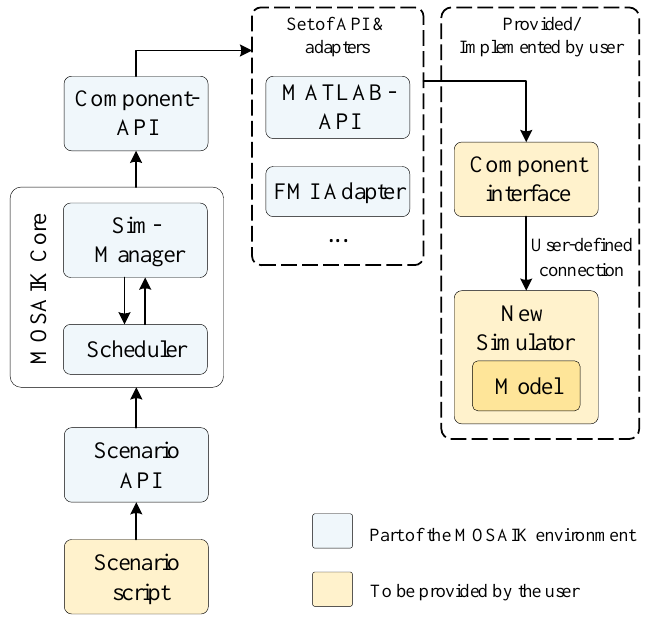
Figure 2. The MOSAIK structure